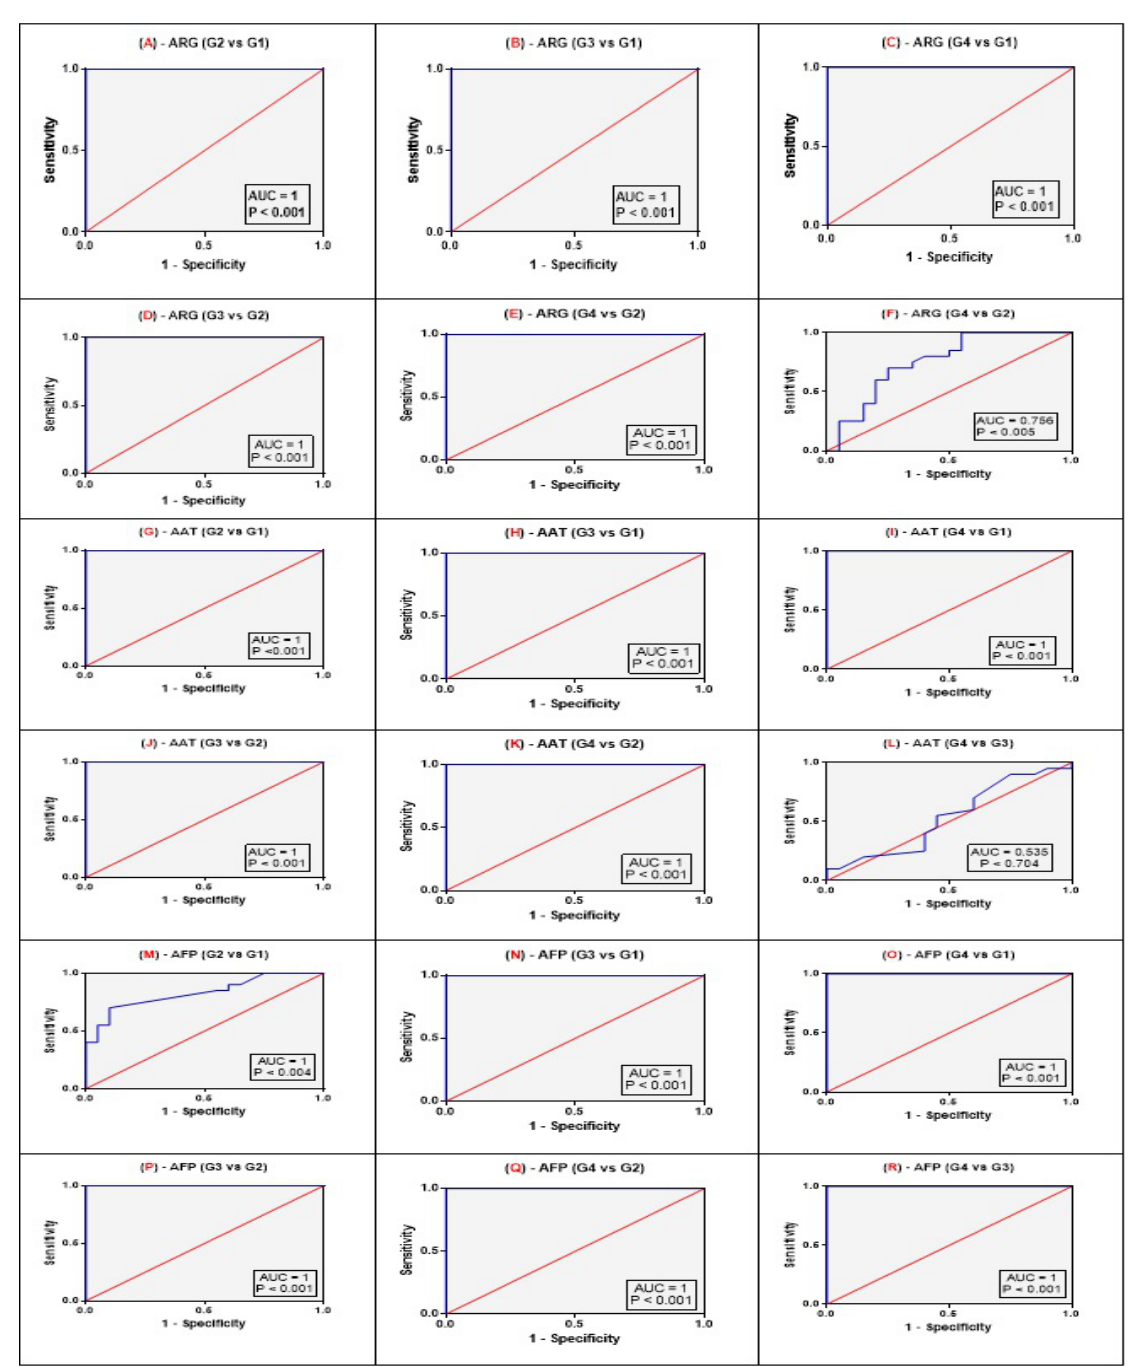
Figure 5. Area under the ROC curve (AUC) and P value for the three studied parameters ((A-F) ARG = Arginase, (G-L) AAT = Alpha-1 antitrypsin and (M-R) AFP = alpha fetoprotein) to discriminated between pathogenic groups (G2, G3 and G4; Nonviremic-HCV, Viremic-HCV and HCC respectively) and control (G1) as well as between pathogenic groups